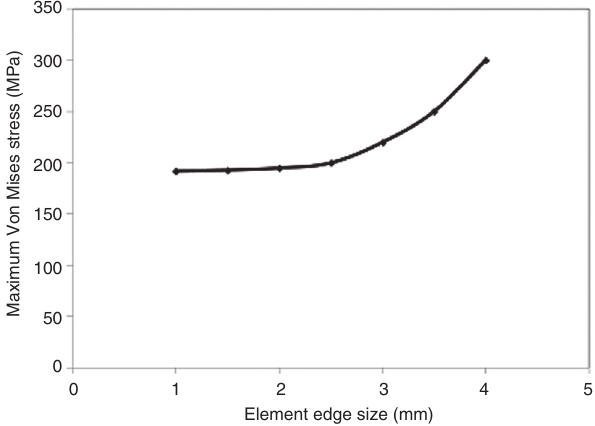
Figure 2 Convergence of maximum Von Mises stress versus maximum element edge